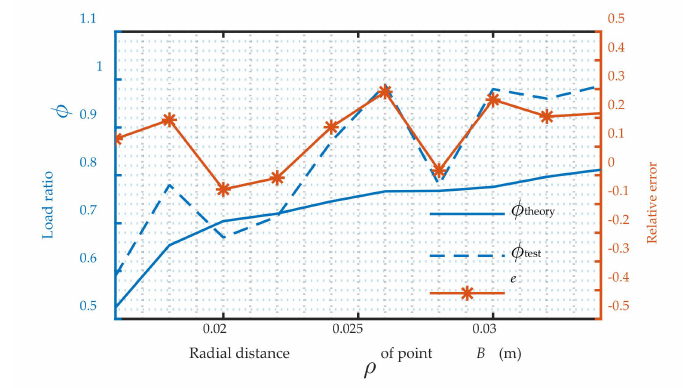
Figure 22. Load ratio φ in configuration II ( AB < OA